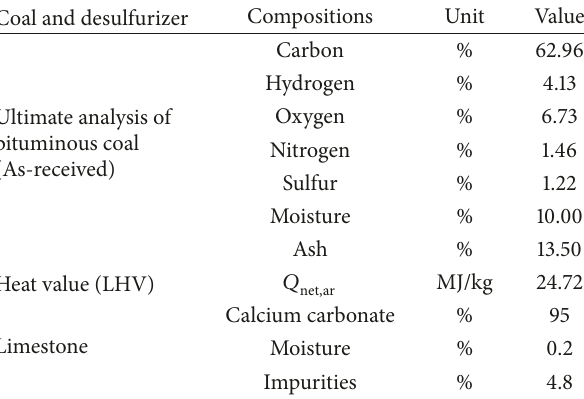
Table 2: Compositions of coal and